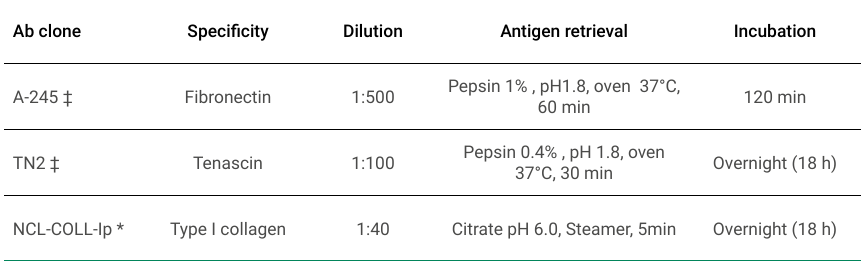
Table 1. Specificity, dilution, antigen retrieval, and incubation of the antibody (Ab) clones. Ab